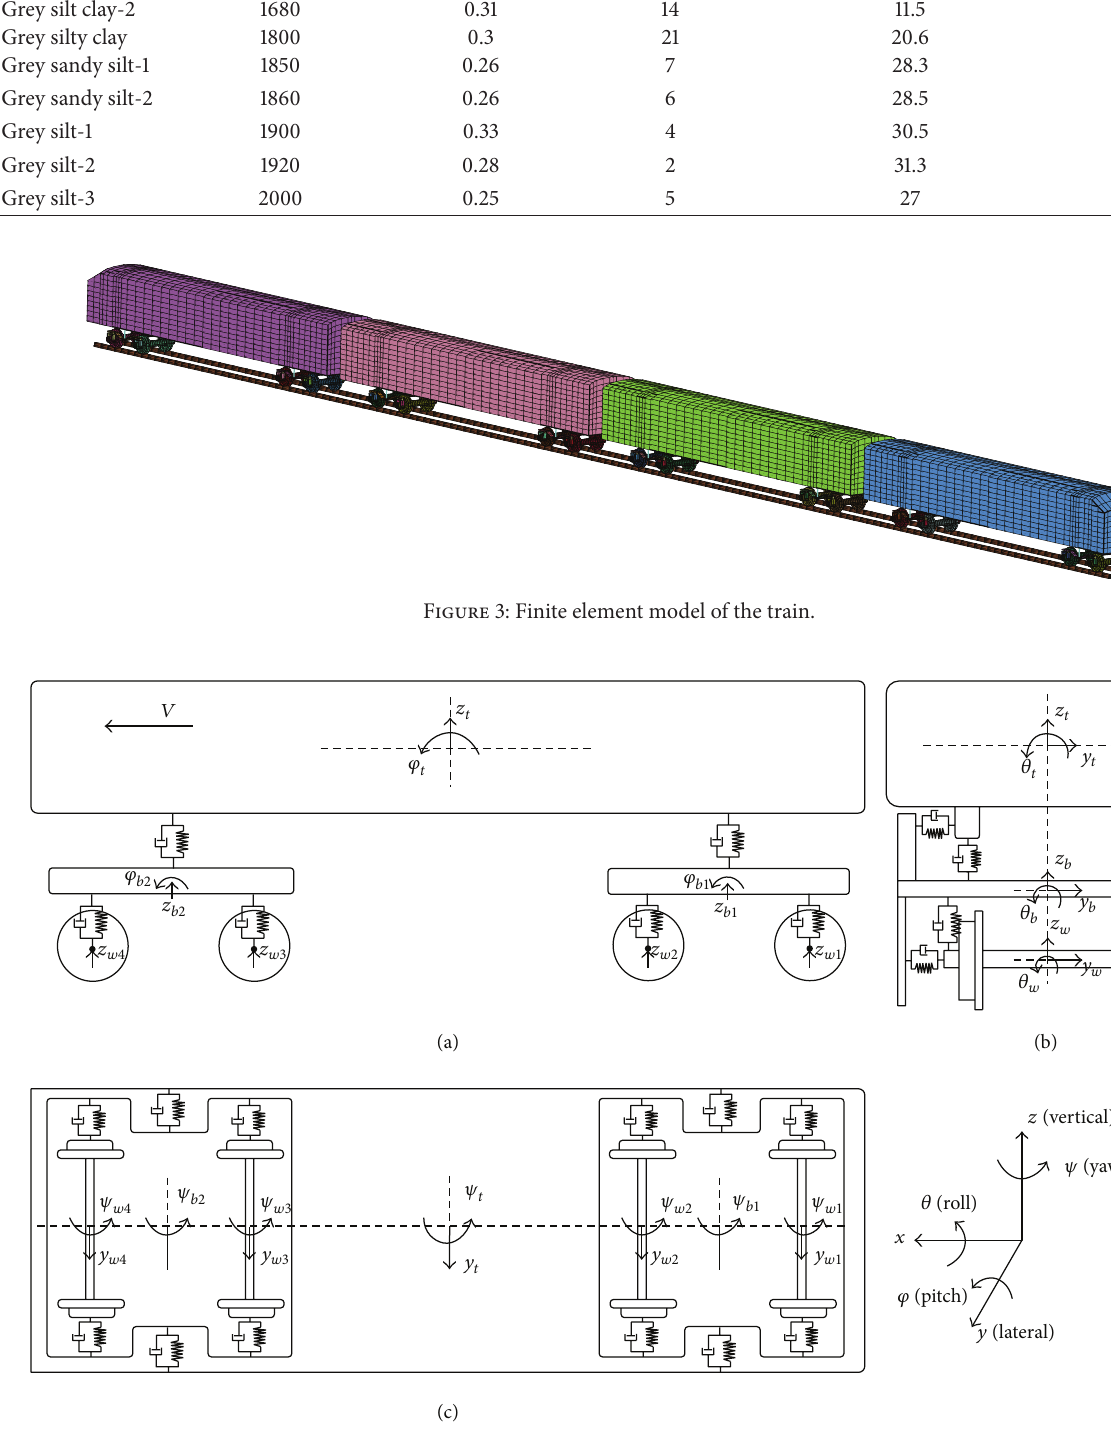
Figure 4: Dynamic analysis model of the